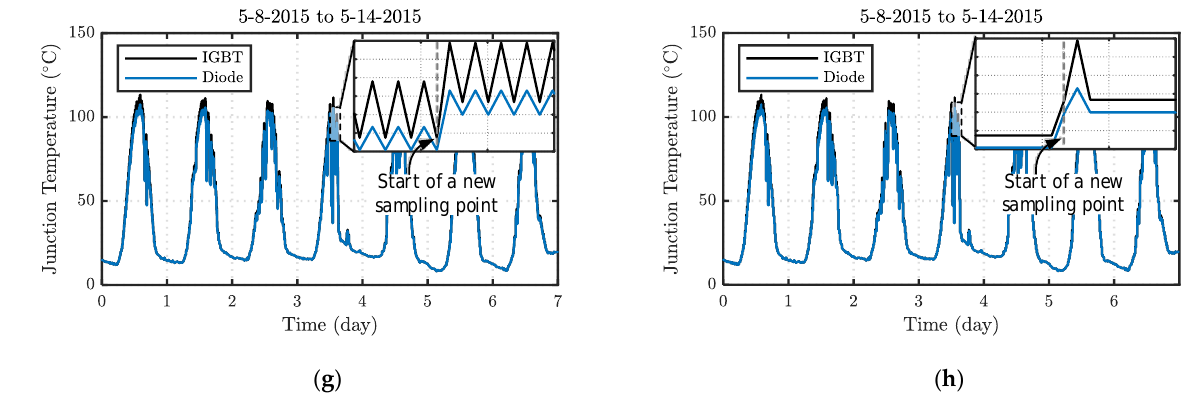
Figure 12. IGBT and diode junction temperature profile for a PV inverter with 7 days of insolation